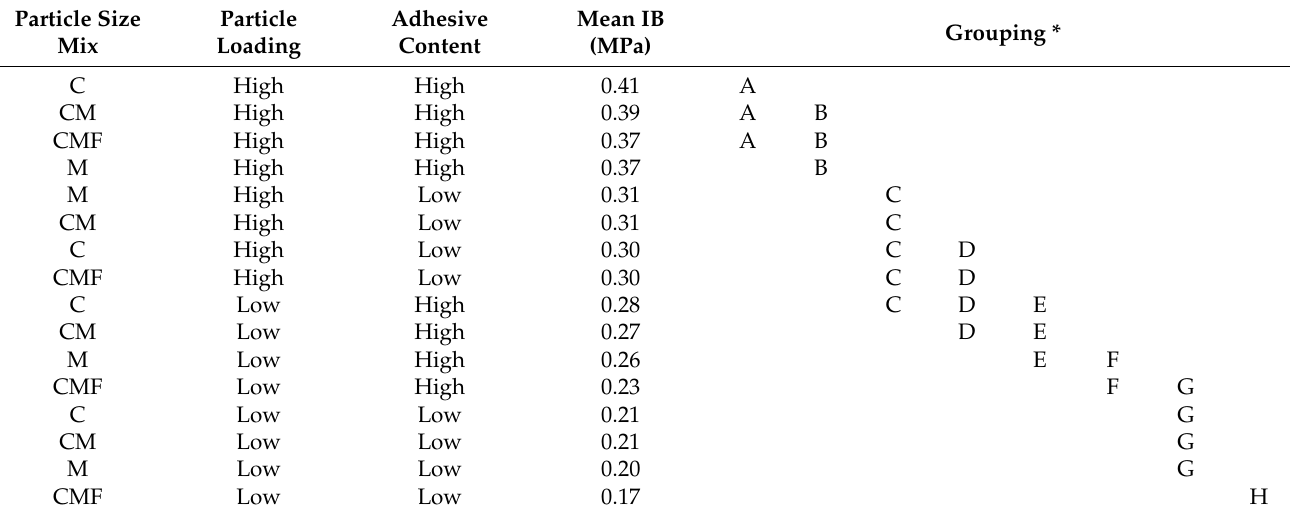
Table A1. Fisher LSD grouping information at 95% confidence level of MDI-ULHPB.